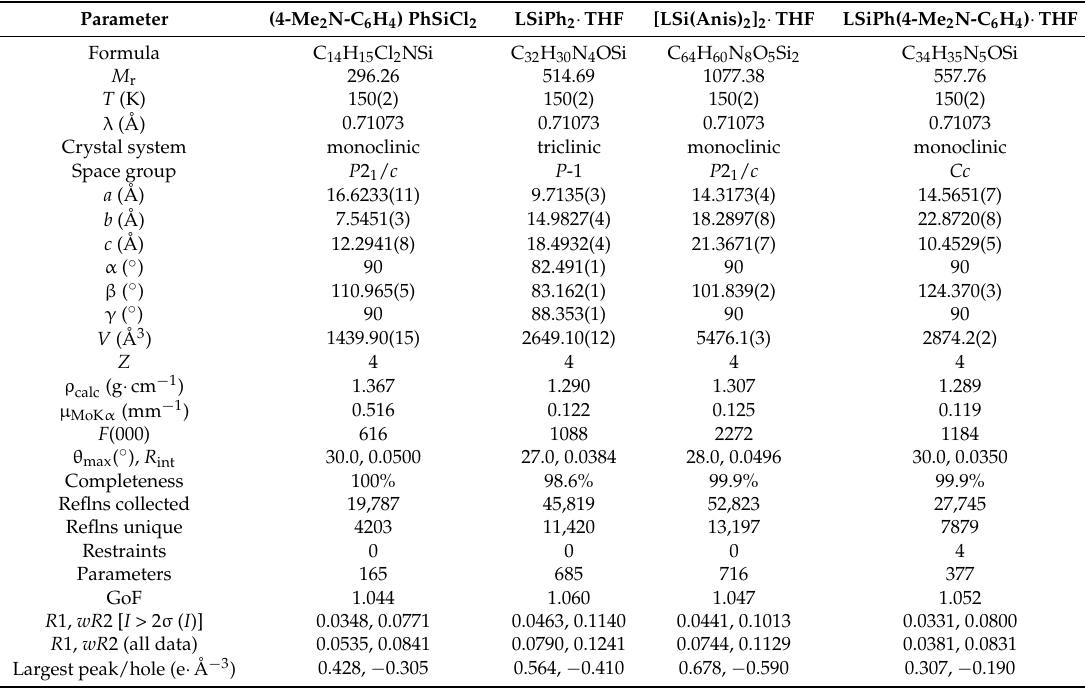
Table 1. Crystallographic data from data collection and refinement for (4-Me 2 N-C 6 H 4 )PhSiCl 2 , LSiPh 2 ·THF, LSi(Anis) 2 ·0.5 THF and LSiPh(4-Me 2 N-C 6 H 4 )·THF.